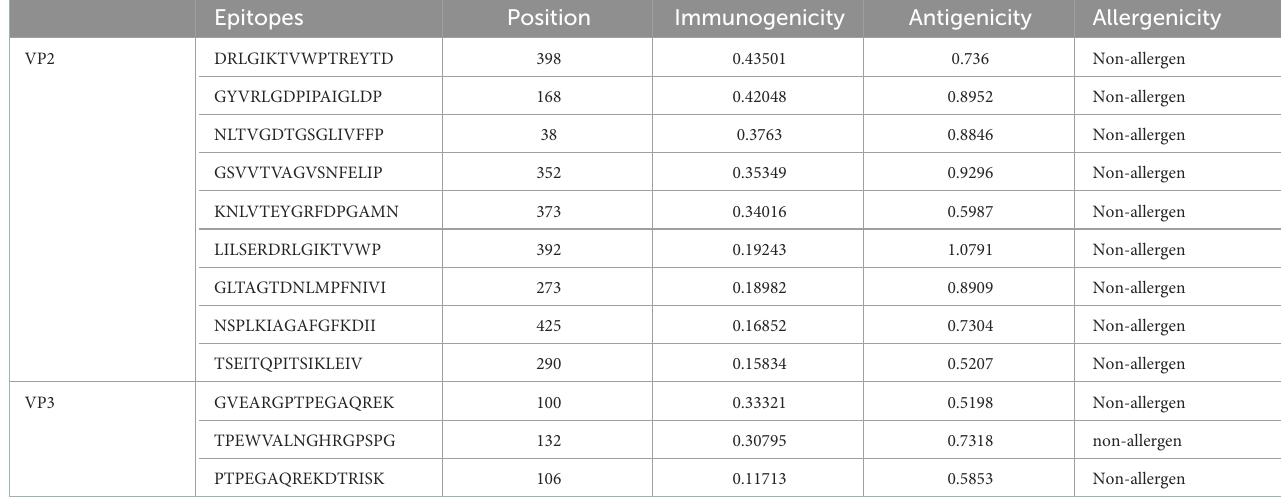
TABLE 3 Final selected linear B-cell epitopes.